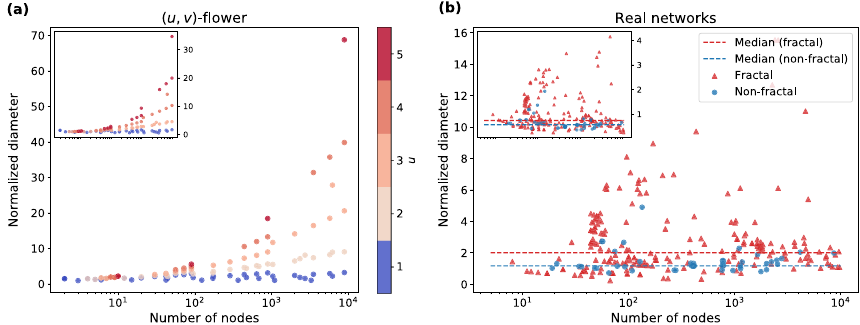
Fig. 24 Normalized diameter (i.e. diameter divided by the logarithm of the size) plotted against the size on a semi‑log scale for the cases of the a ( u , v )‑flower, b real networks. On subplot a the coloring is based on the u parameter of the model. The insets are showing the semi‑log plots of the normalized average path length plotted against the size of the network. The difference between the distribution of normalized diameter and the normalized average path length of the fractal and non‑fractal real networks are statistically significant (Mann–Whitney U rank test’s p ‑value: 7.66 · 10 − 6 and 1.19 · 10 − 5 ). The results for the other models, as well